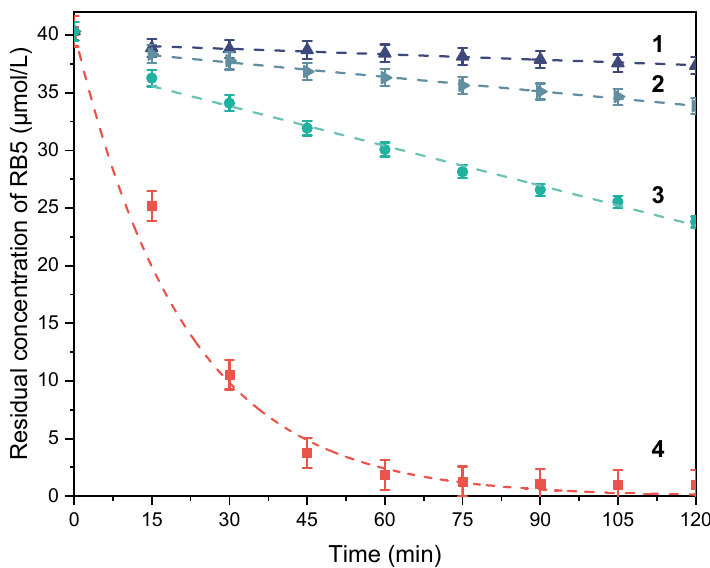
Figure 4. Degradation kinetics of RB5 catalyzed by Fenton polymer composite PP- g -MA/F1 (80/20) with different particle sizes: ( 1 ) PP- g -MA/F1 (80/20)-G granules with Ø = 3.1 mm, ( 2 ) PP- g -MA/F1 (80/20)-C crushed with Ø = 0.9 mm, ( 3 ) PP- g -MA/F1 (80/20) powder with Ø = 0.2 mm and ( 4 ) F1 for comparison.